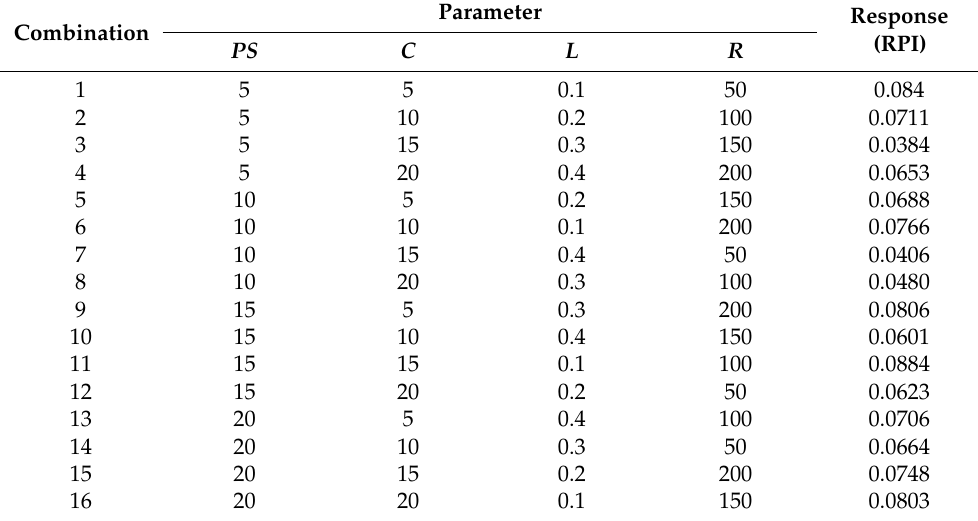
Table 3. Orthogonal array and response